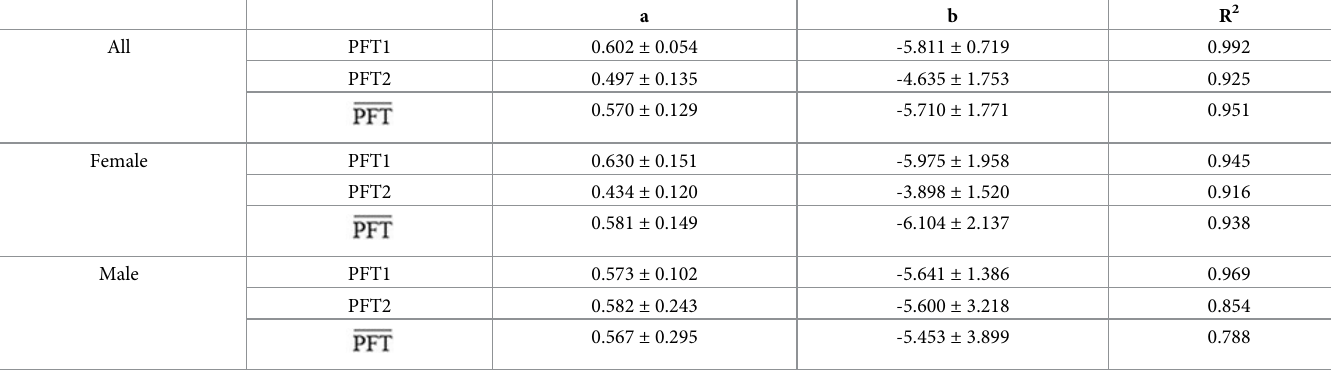
Fig 2 illustrates that, in general, the top 10% of athletes in PFT ranking account for the highest proportion of the top 8 athletes in the four competitions. As the PFT ranks lower, this proportion is also lowers. This feature is more pronounced for the statistics of all athletes ( Fig 2A–2D ) than for females ( Fig 2E–2H ) and males ( Fig 2I–2L ) specifically. In addition, the pro- portion of athletes in the top 50% and bottom 50% of the PFT was also counted, which shown in Fig 2 with red ladders. Apparently, the top 50% account for a higher proportion of the top 8 athletes (about 2/3). For female Taekwondo athletes, the top 50% in the PFT accounted for a higher proportion in the top 8 (Fig 2E–2H) , implying that compared with male athletes, physi- cal fitness is more crucial in competition performance for female athletes. A linear correlation analysis was performed on the proportions of athletes with different PFT ranking percentages among all the top 8 athletes ( Fig 3 ), all coefficients are calculated within the 95% confidence interval and p value less than 0.001. The high correlation coefficient (r = 0.914) illustrates that there is a strong negative correlation between an athlete’s probability of achieving a top 8 rank- ing in a competition and their percentage ranking in the PFT. Given the sample size of athletes in this study is 638, the results are considered to be statistically significant. However, it also should be noted that due to the lack of data on all athletes’ years of training and whether they have achieved international acclaims, we cannot exclude the effect of these covariates on ath- letes’ competitive performance. Table 4. The fitting coefficient (a and b), the Goodness of Fit (R 2 ) and the number of athletes (N) in Fig 1D and 1E. a b R 2 All